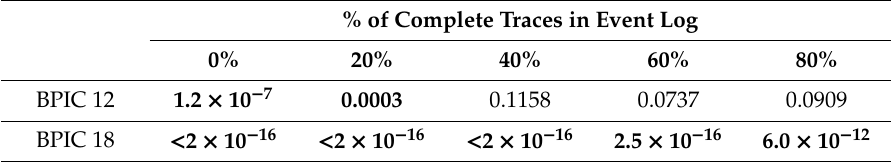
Table 5. Pairwise Comparisons against the baseline using Wilcoxon rank-sum